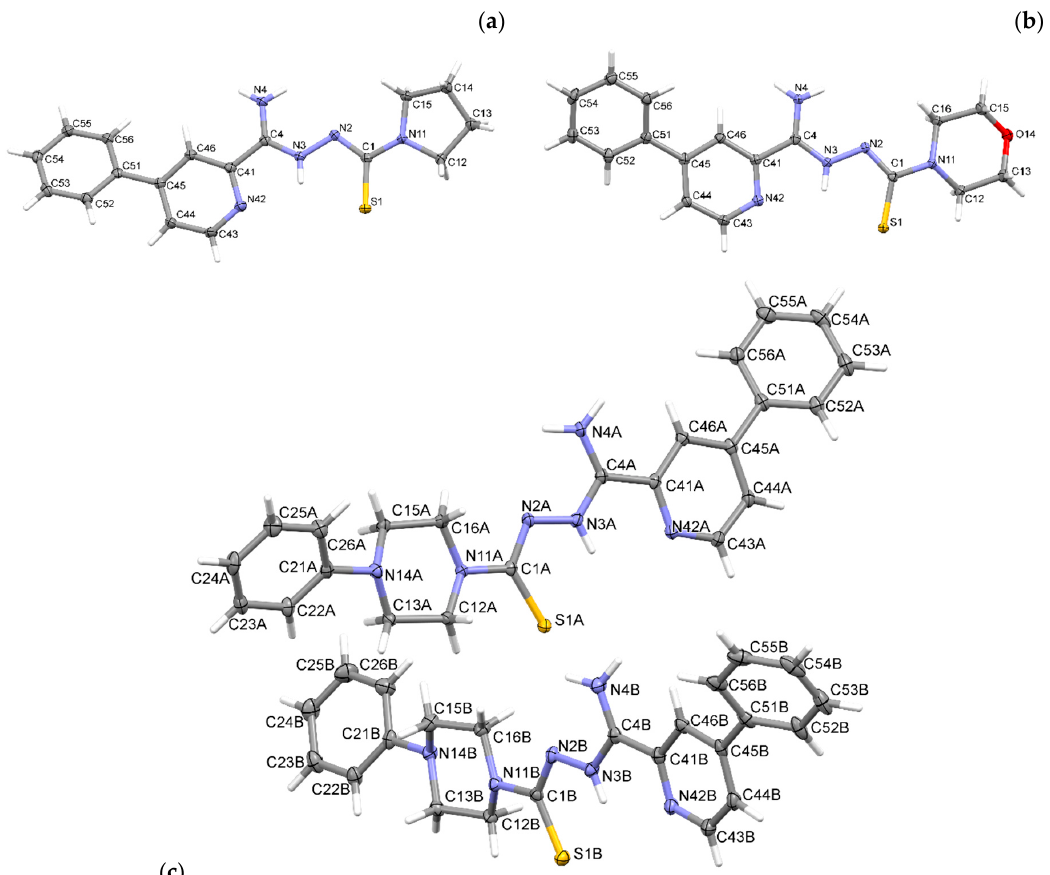
Figure 7. The molecular structures of compounds ( a – c ), with atom-labeling schemes. Displacement ellipsoids are drawn at the 50% probability level, and H atoms are shown as small spheres of arbitrary radii. Drawings were prepared with Mercury software.